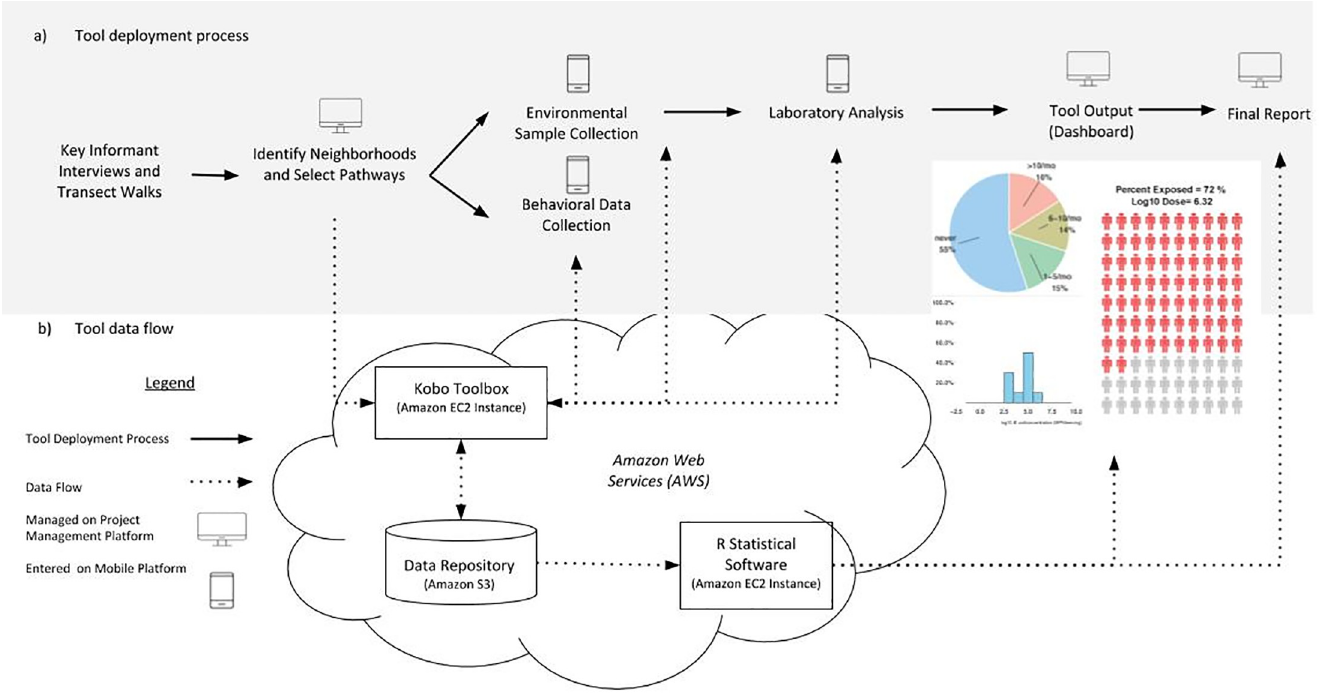
Fig 1. The SaniPath Tool process. a) The top half of the diagram uses solid arrows to illustrate the steps in a SaniPath Tool deployment from preliminary Key Informant Interviews to generating a final report. b) Dashed arrows represent the flow of data through different components of the web platform. EC2 Instances of Kobo Toolbox for mobile data collection and R statistical software for analysis, are hosted on cloud-based Amazon Web Services. A data repository was created using Amazon Simple Storage Service (S3) to store all the data. In some cases, data may flow in both directions (represented by a two-sided arrow). The computer and mobile icons represent whether the data are managed via the project management platform or collected via mobile